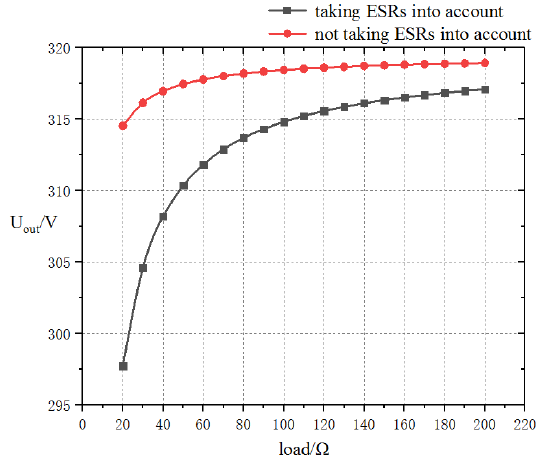
Figure 11. Curves of the output voltage with different load.